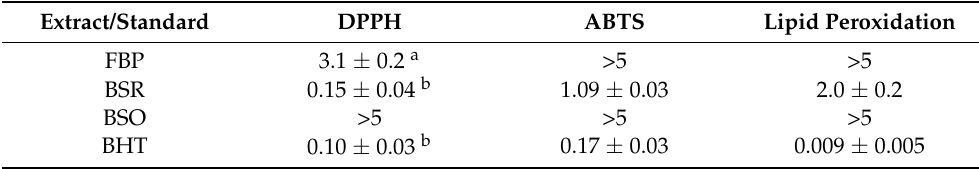
Table 2. Free radical scavenging activity (DPPH and ABTS) and inhibition of lipid peroxidation of pulp and seed extracts of C. album berries presented as EC 50 values (mg/mL). Extract/Standard